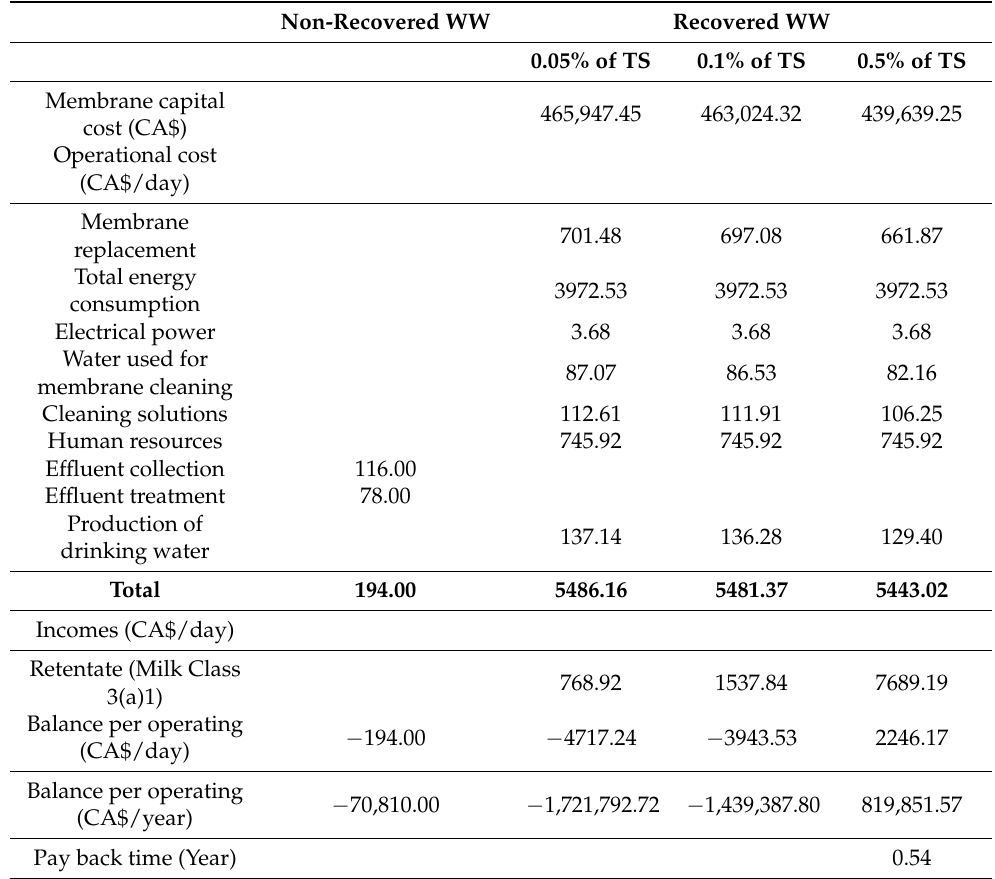
Table 5. Economic evaluation of white wastewaters recovered by implementing a new reverse- osmosis system in virtual dairy plants generating 200 m 3 of white wastewaters per day compared to non-valorization